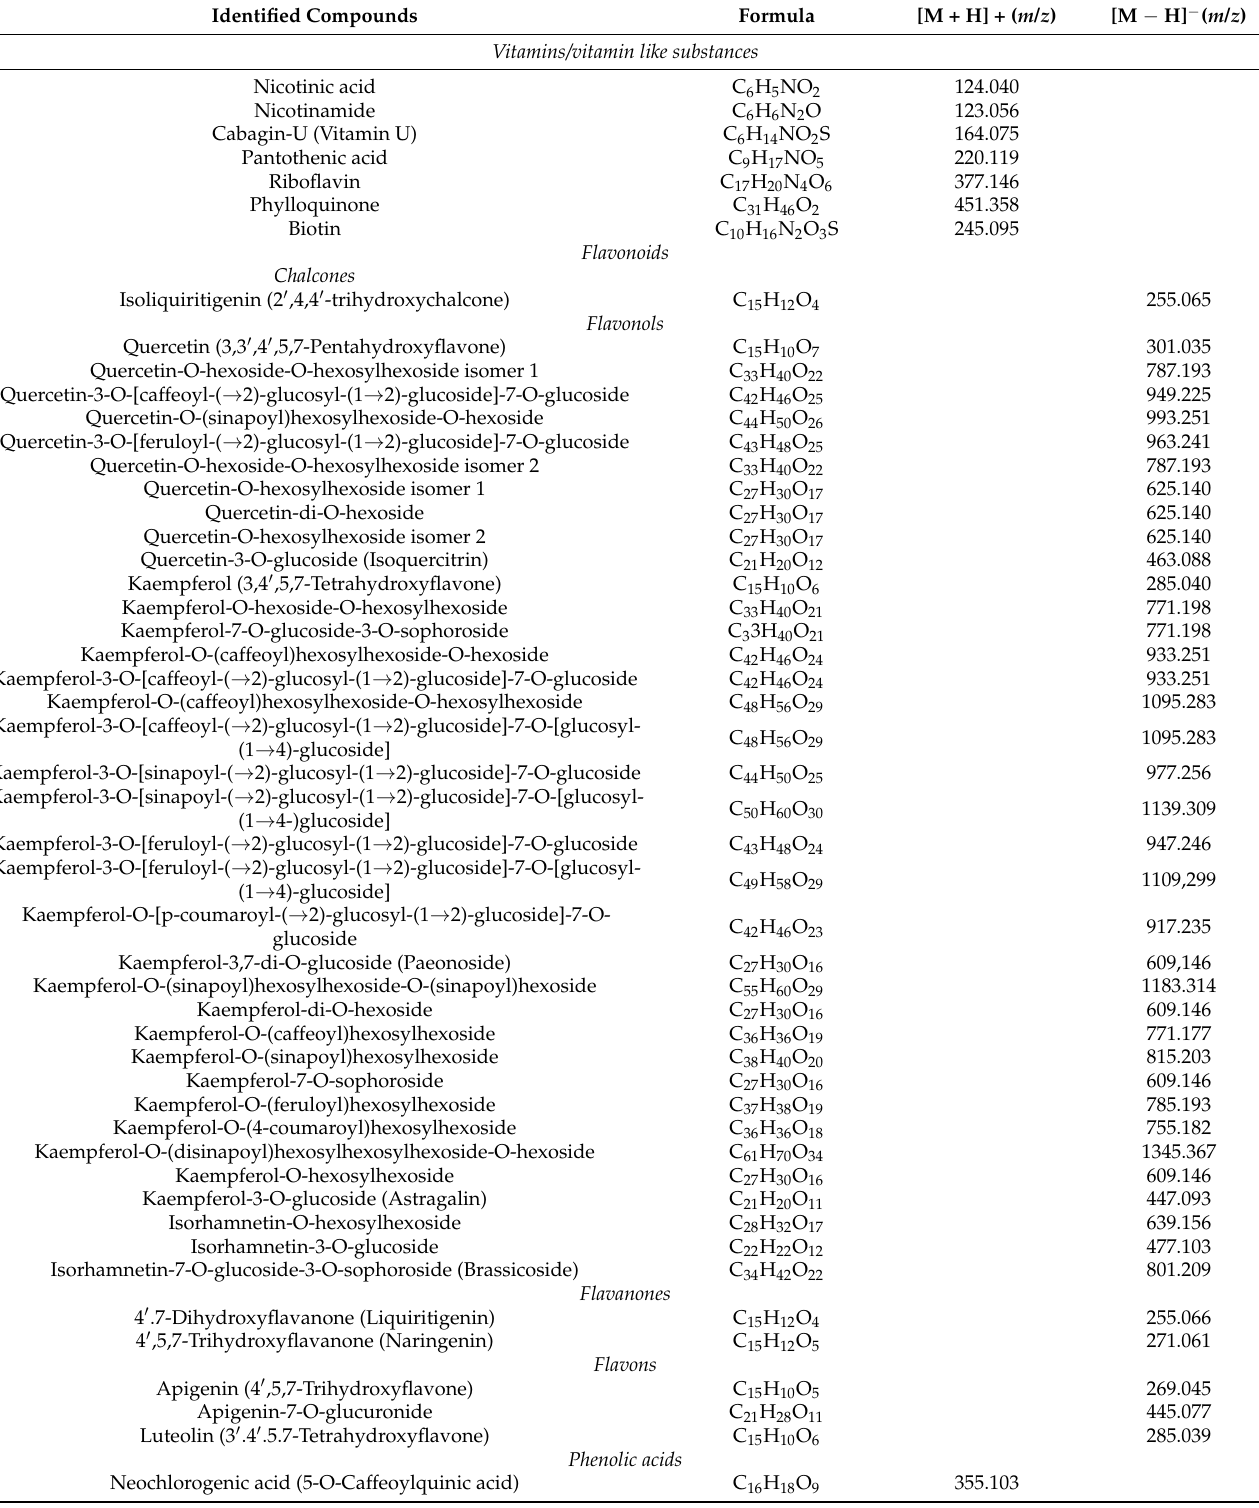
Table 2. Identified phytochemical compounds of broccoli fresh green leaves-originated green juice (GJ). Identified